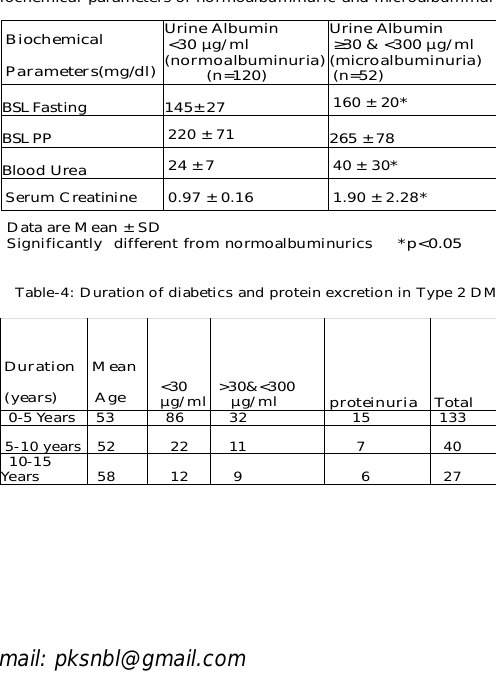
Biochemical parameters of normoalbuminuric and microalbuminuric .